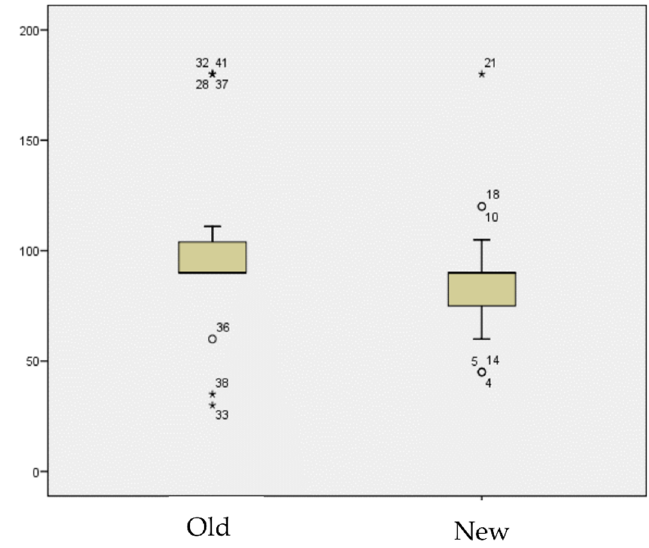
Abbreviations: MSSA, methicillin-susceptible Staphylococcus aureus; MRSA methicillin-resistant Staphylococcus aureus; M, male; F, female.